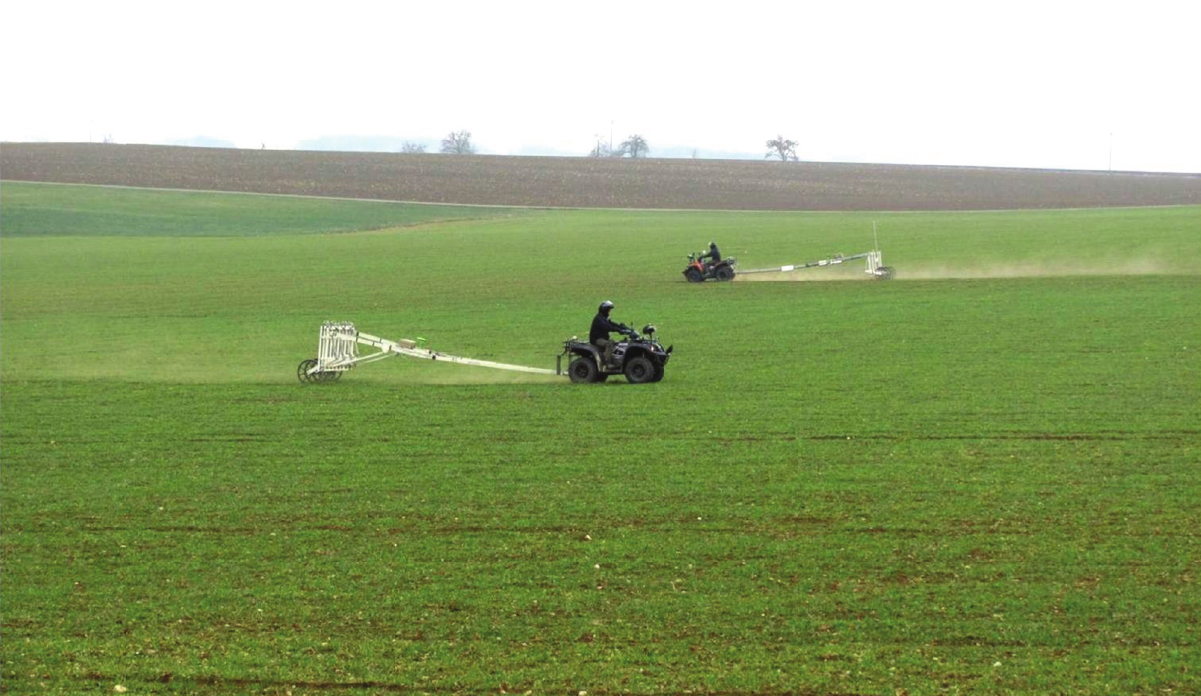
Figure 4. Moto solutions